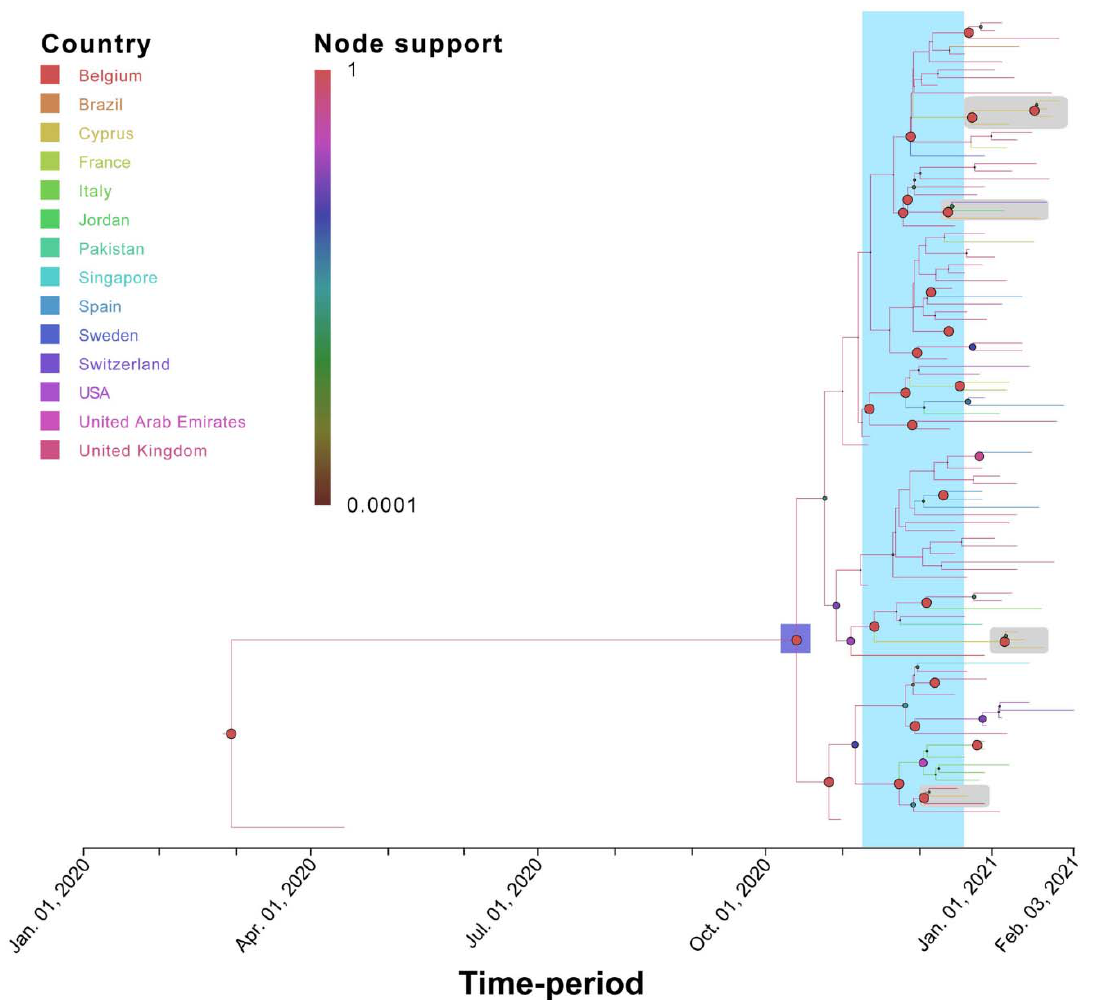
Figure 7. Time-scaled migration history for the B.1.1.7 dataset. The link between branch color and the inferred location (Country) is shown in the top left of the figure. The size and color of the circles at the nodes (representing inferred common ancestors) indicate their posterior support (node support); the level of node support (highest = 1 and lowest = 0.0001) corresponds to the size of the circle (higher support = larger circle size). The link between color and posterior node support is shown in the top left of the figure. The purple-shaded area represents the 95% HPD of the B.1.1.7 tMRCA. The light blue-shaded area represents the time of first introduction of B.1.1.7 into Cyprus. The gray-shaded boxes indicate the Cypriot samples. The x -axis representing the time-period of the reconstruction was generated by the maximum clade credibility summary tree.